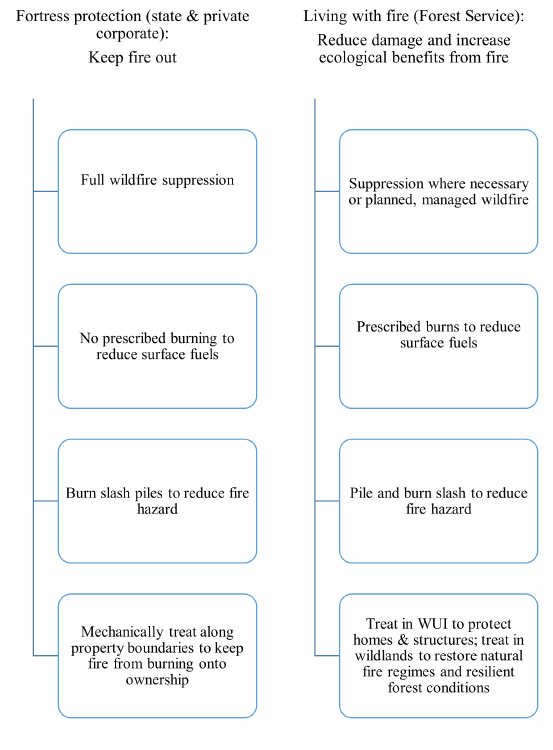
Fig. 4 . Fortress protection vs. living with